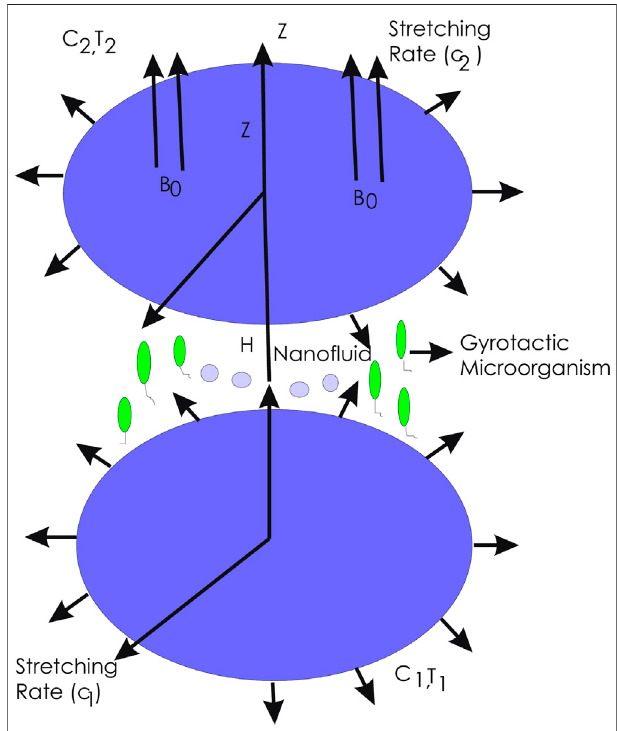
FIGURE 1 | Geometry of the